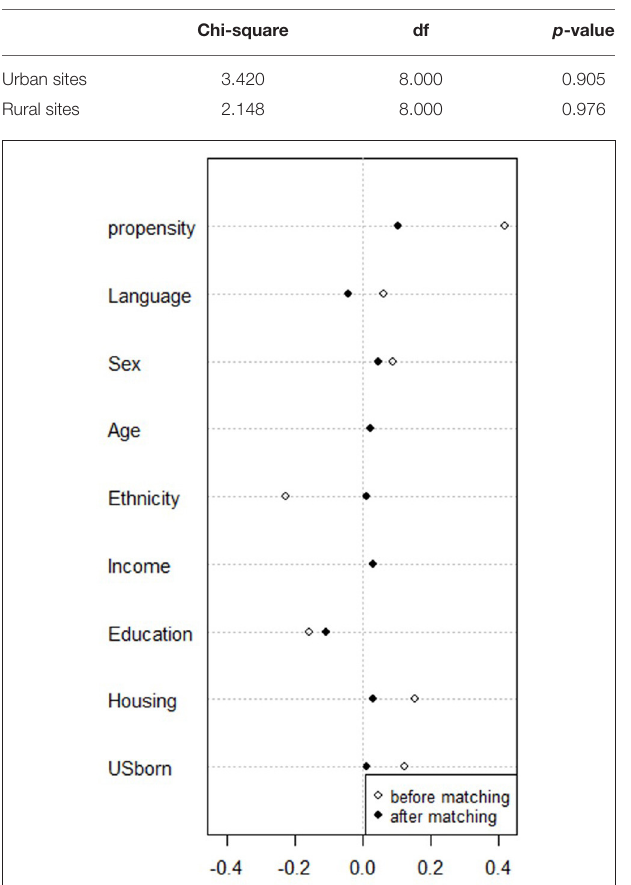
FIGURE 1 | Dotplot of standardized mean differences (Cohen’s d) for all covariates before and after matching survey participants in Madison, WI and Seattle, WA ( N = 512).